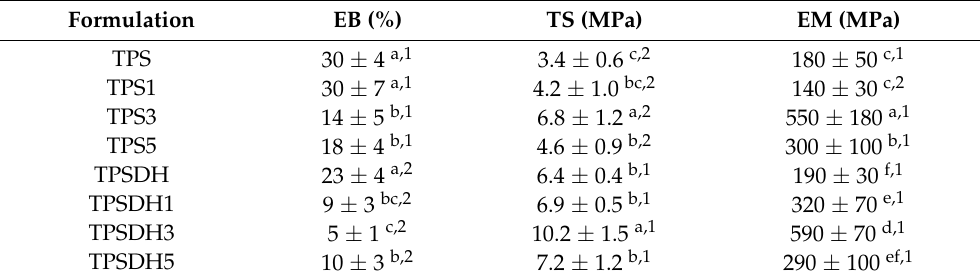
Table 4. Mechanical properties in terms of elongation at break (EB%), tensile strength at break (TS), and elastic modulus (EM) of thermoplastic starch (TPS) and TPS modified by dry heating (TPSDH) films with different contents of cellulose microfibers (CMFs).